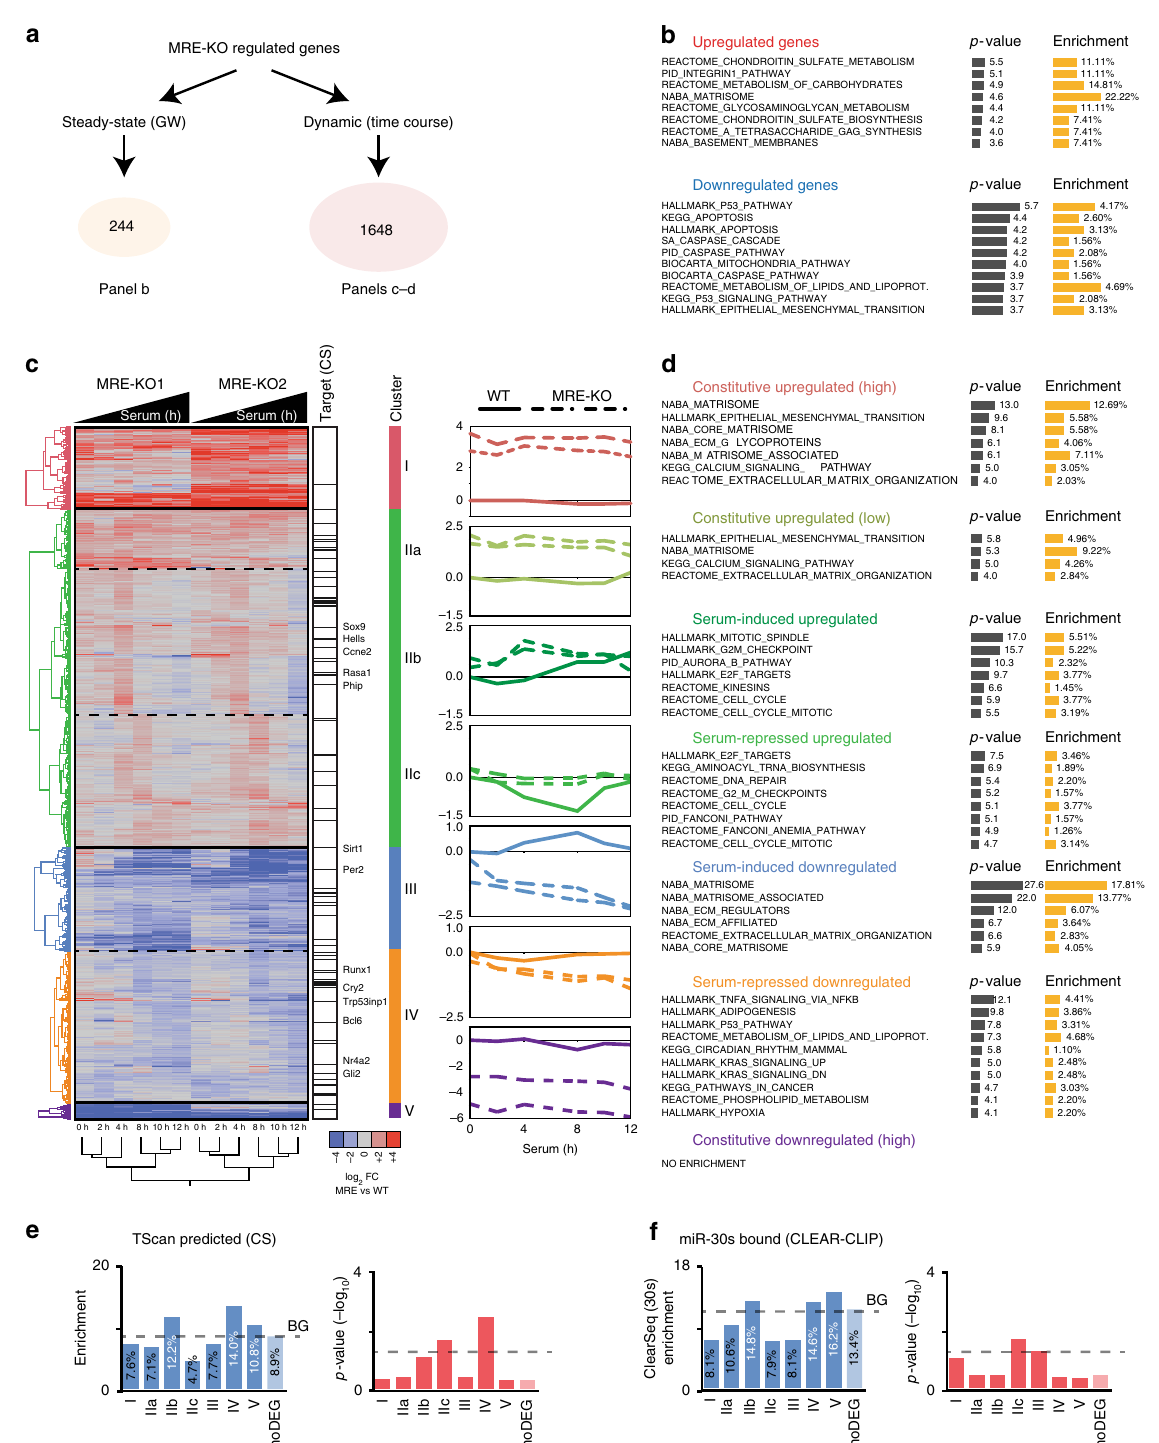
Fig. 7 MRE-KO cells display altered gene expression. a Differentially expressed genes (DEGs) between WT and MRE-KO clones were determined by RNA- seq either at steady-state (growing cells, n = 244) or upon serum stimulation ( n = 1648) of quiescent cells. b Enriched biological functions among GW- DEGs were retrieved by Gene Set Enrichment Analysis (GSEA), calculating the overlap with curated gene sets (Molecular Signatures Database; shown those with a p -value < 0.001). c Unsupervised hierarchical clustering of serum stimulation DEGs (1648 genes) identi fi es fi ve major clusters (I – V) showing different patterns of gene regulation. Cluster II was further split into three sub-clusters (IIa-b-c) having different behaviour in terms of serum-regulation dynamics. MiR-30 family conserved targets predicted by TargetScan are also reported. Right charts: median gene regulation in each (sub)cluster is reported over the time course; MRE-KO data were normalised over basal expression level (i.e., quiescent state, 0 h) of WT cells. d Enriched biological functions among clusters shown in b . e , f Enrichment (and chi-square, p -value by Contingency Test) of miR-30 targets across each cluster was calculated either using predictions ( e ) or validated interactions ( f